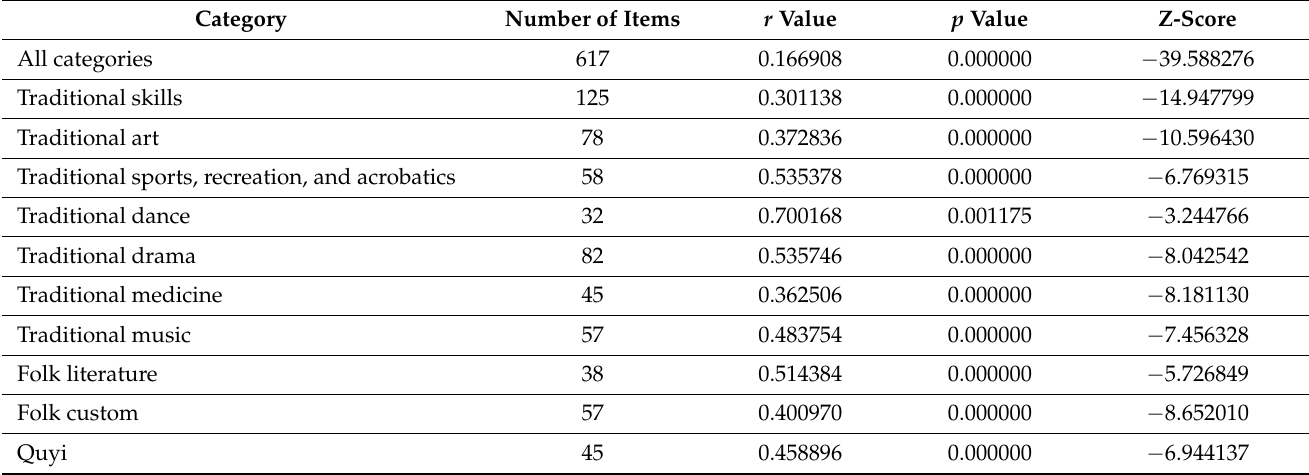
Table 2. Nearest neighbor index (NNI) of intangible cultural heritage (ICH)